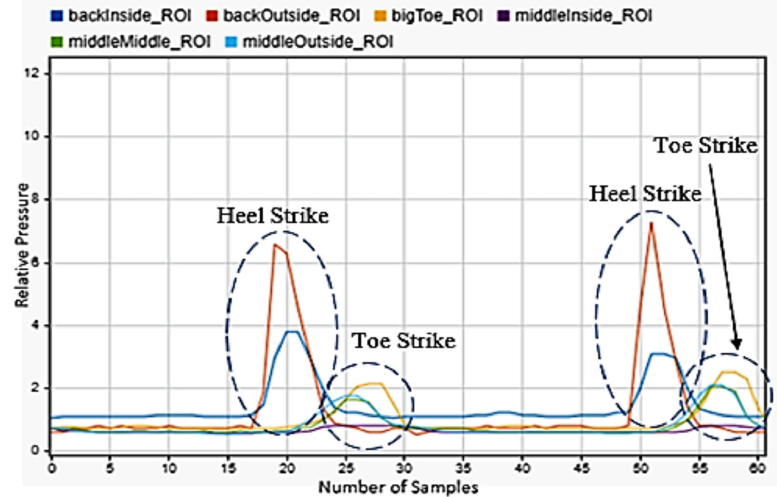
Figure 5. Running motion sensor readings for the left foot.